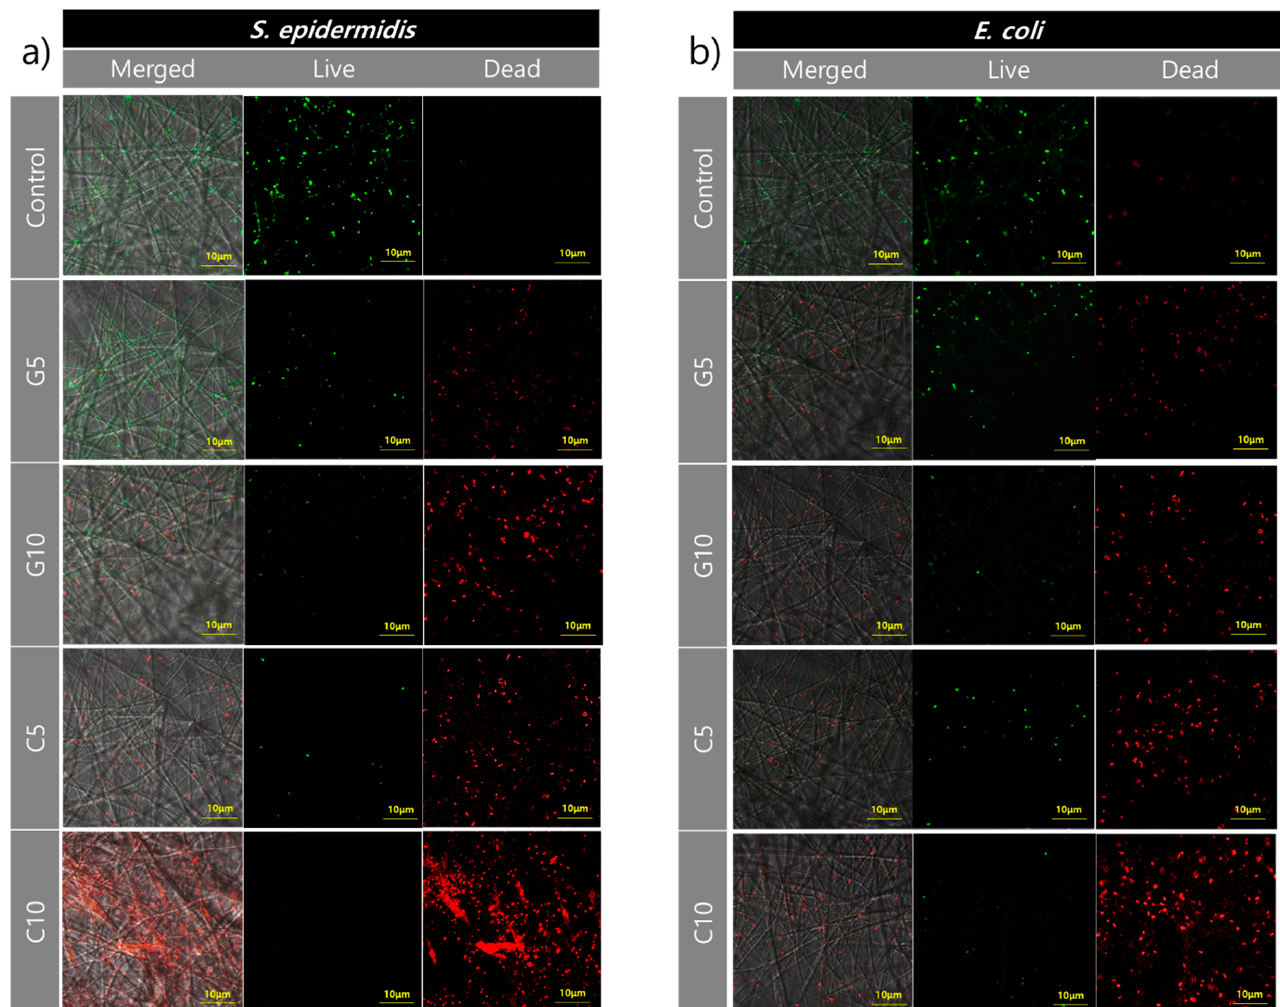
Figure 5. Fluorescence microscopic images of a Live/Dead bacterial cell viability assay. Representative images of ( a ) S. epidermidis and ( b ) E. coli cultured on carvacrol or geraniol-loaded PLA nanofiber webs after 24 h of incubation (green refers to live bacteria and red refers to dead bacteria).